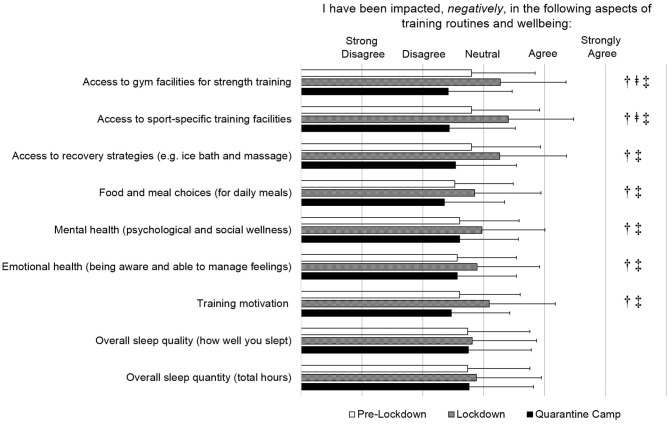
Survey section 2; athlete's training routines and wellbeing responses. All questions were phrased: “I have been impacted, negatively, in the following aspects”: The questionnaire used a 5-point scale, with 1 and 5 representing strongly disagree and strongly agree ratings, respectively, and using 1-point increments. †Significant difference (p < 0.05) between pre-lockdown and lockdown.Significant difference (p < 0.05) between pre-lockdown and “quarantine” camp.‡Significant difference (p < 0.05) between lockdown and “quarantine” camp.